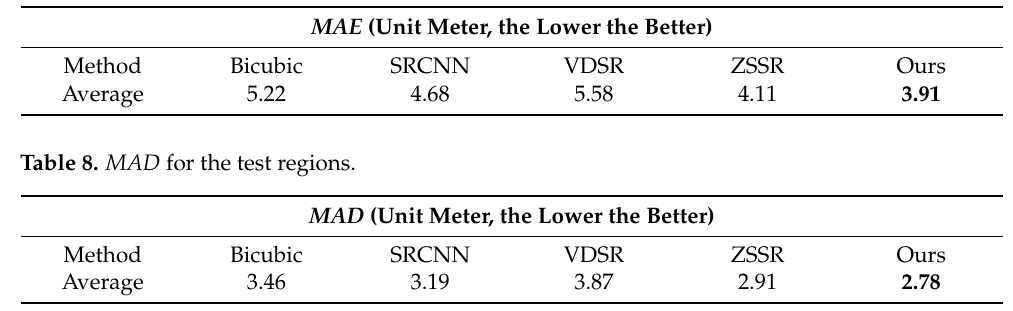
Table 7. MAE for the test regions.